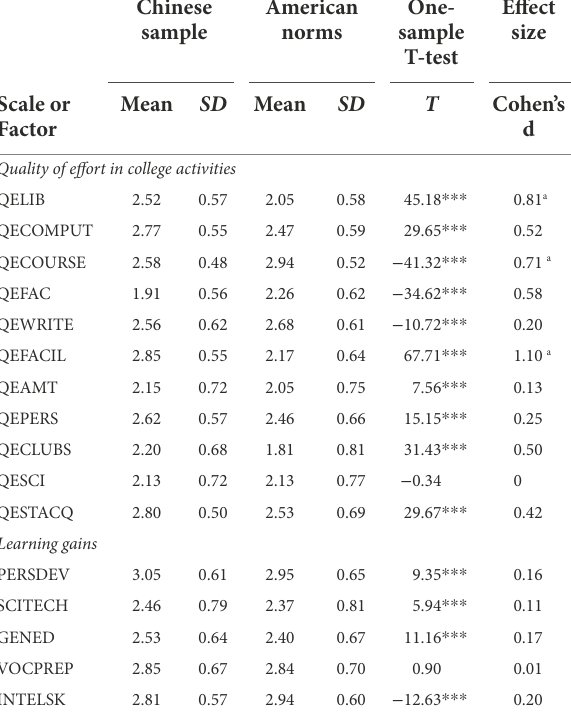
TABLE 3 Differences in learning experience between Chinese and American undergraduates. Chinese